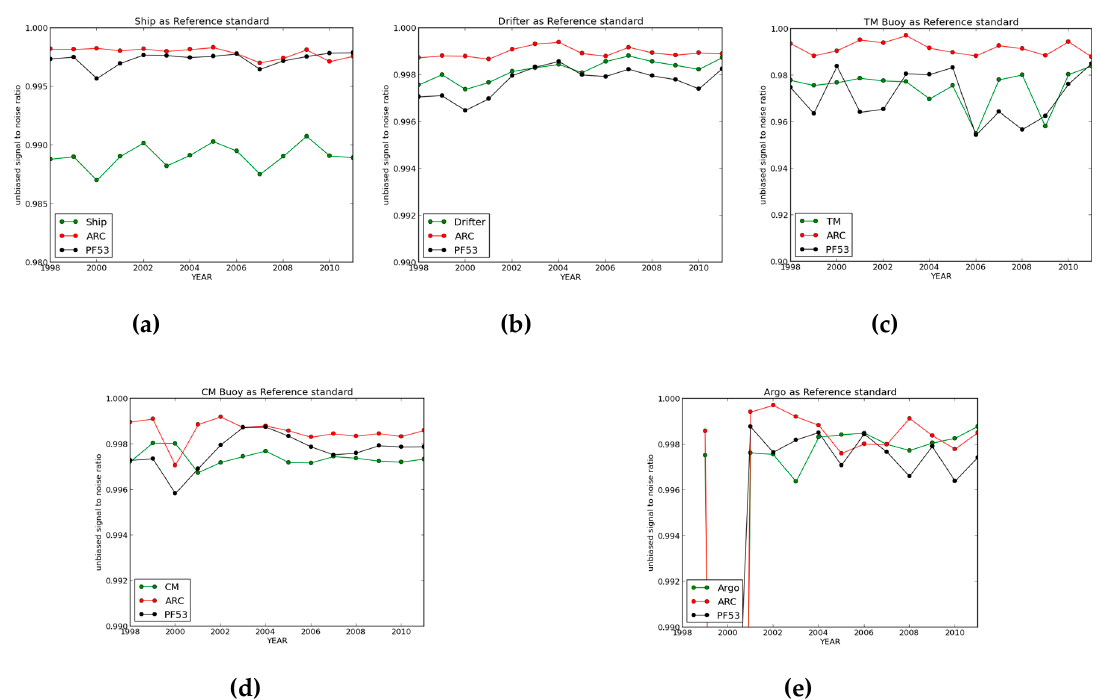
Figure 4. ( a – e ): SNR UB time series for PF53 (green), ARC (red) and in situ data (black), with in situ data standard ranges from ( a ) drifters, ( b ) ships, ( c ) tropical moorings, ( d ) coastal moorings, and ( e ) Argo floats.